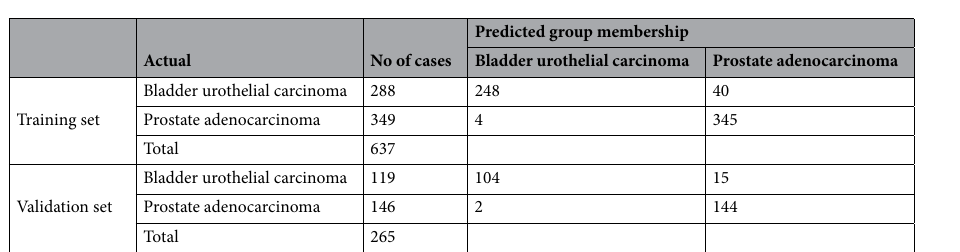
Table 2. Hit ratios for the model based on urothelial lineage gene expressions. 93.1% of training set cases correctly classified. 93.6% of validation set cases correctly classified.